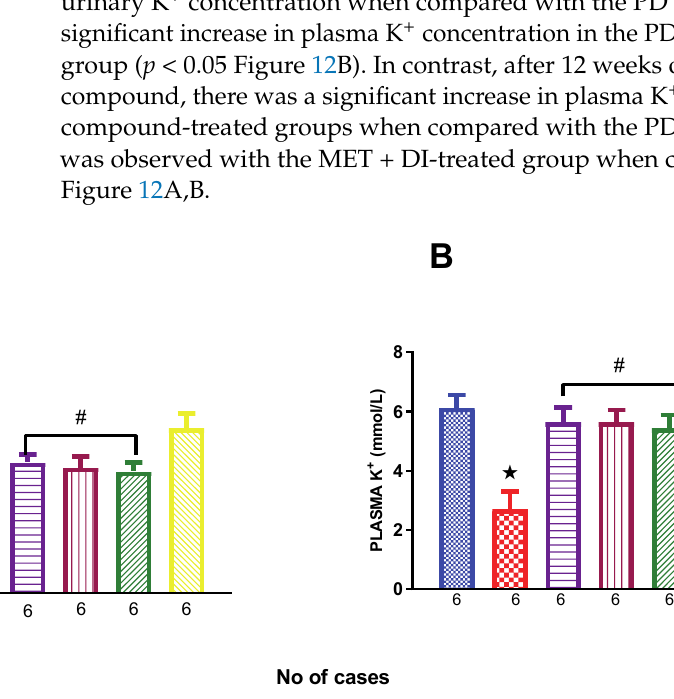
(MET + HFHC), rhenium (V) compound and diet intervention (Re + DI) and rhenium (V) compound